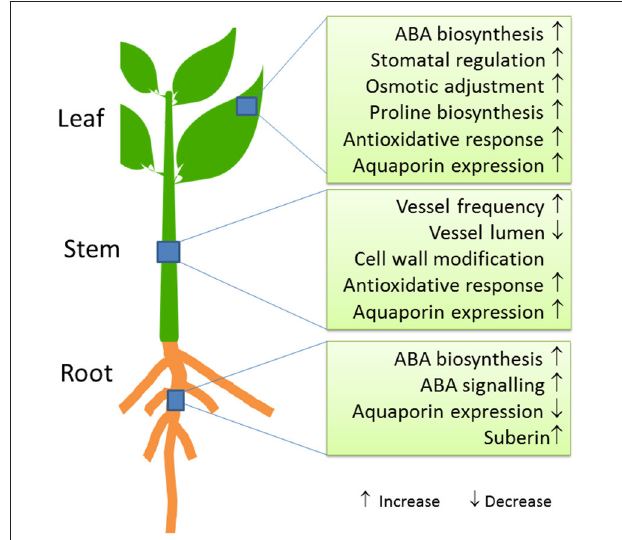
FIGURE 2 | Molecular and physiological key responses of trees to drought